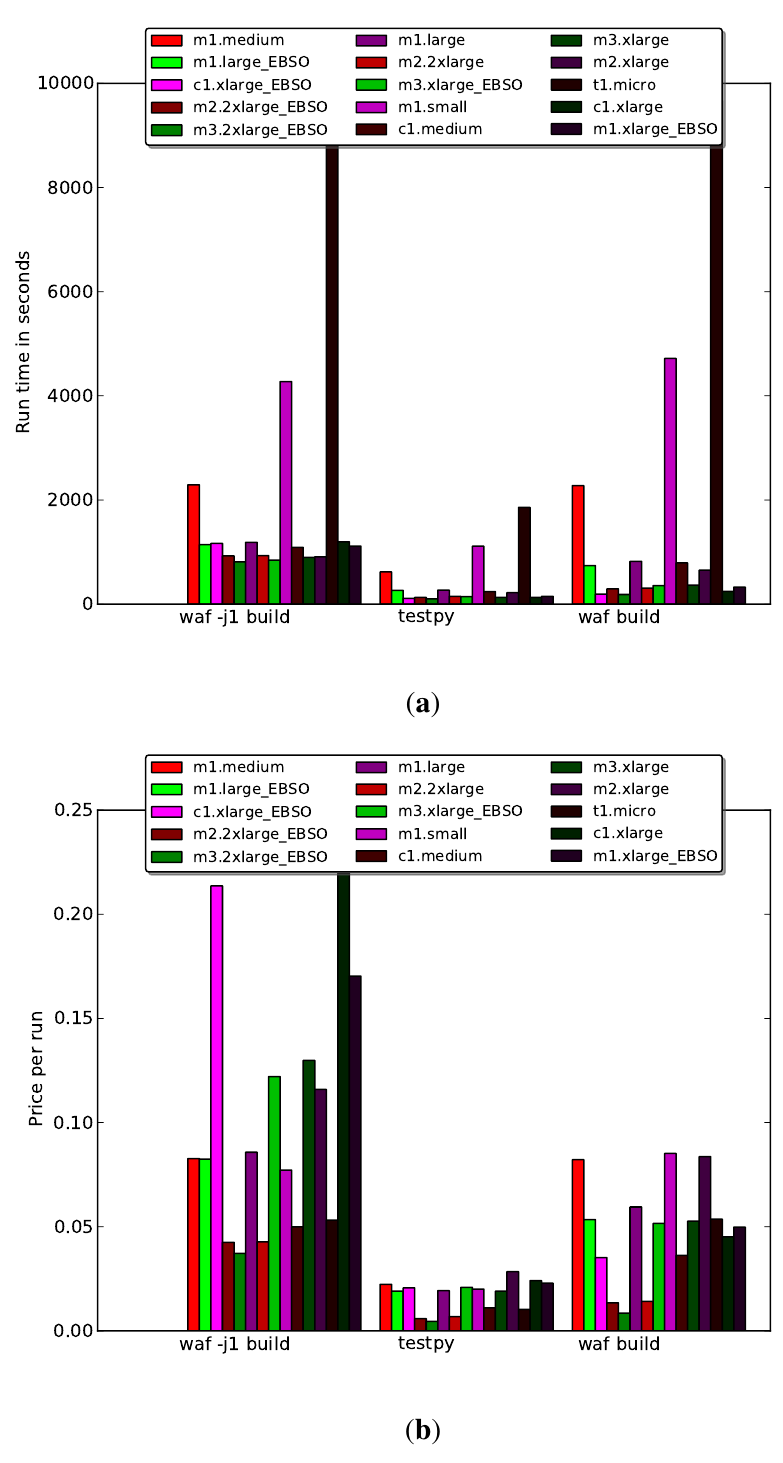
Figure 10. Simulation benchmarking results on Amazon Web Services (AWS). ( a ) Run times for the three benchmarking tests on different instances; ( b ) simulation times as a function of the number of nodes used when running the three benchmarking